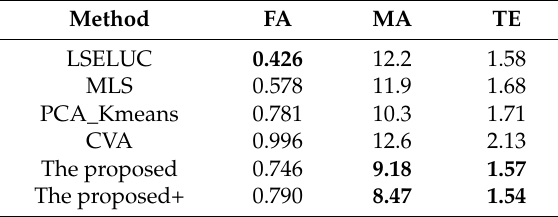
Figure 9. Landslide on Landtau Island dataset: Binary change detection map generated by different methods: ( a ) LSELUC [45]; ( b ) MLS [46]; ( c ) PCA_Kmeans [43]; ( d ) CVA [36]; ( e , f ) the proposed approach with the Otsu binary threshold and a manual threshold, respectively. Table 3. Comparison between other methods and the proposed approach for the Mexico dataset.